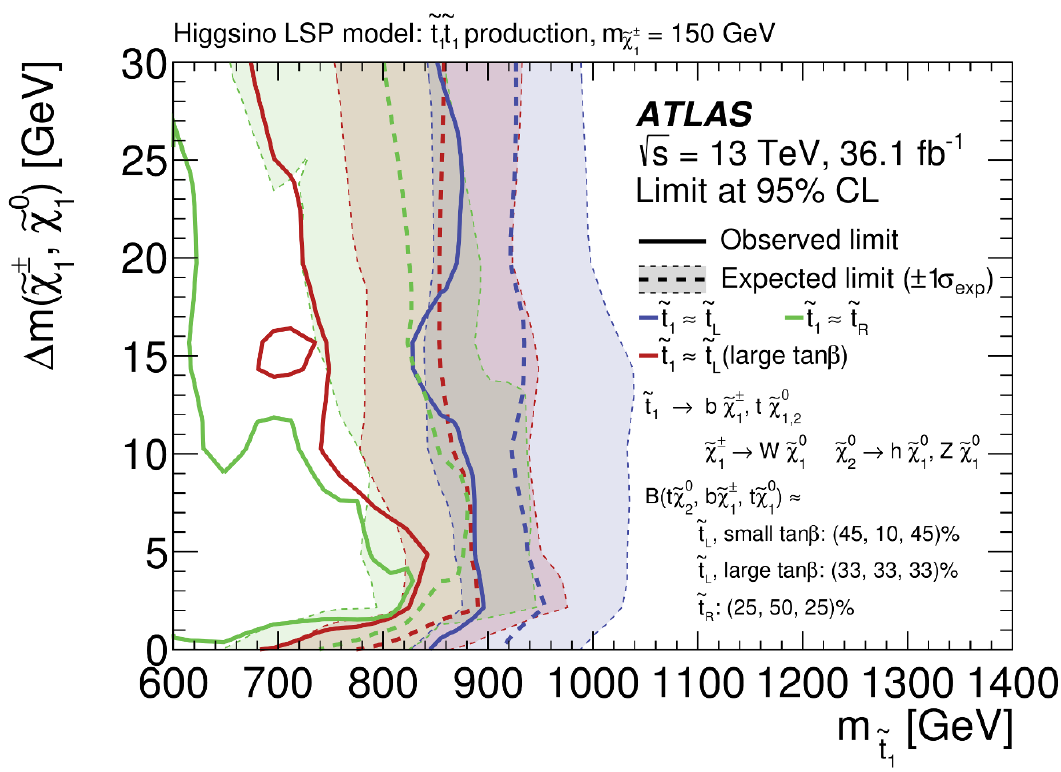
Figure 24 . Expected (dashed) and observed (solid) 95% excluded regions in the plane of (cid:1) m (~ (cid:31) (cid:6) ~ (cid:31) 0 for direct stop pair production in the (cid:12)xed m = 150 GeV higgsino LSP 1 ) versus m ~ t 1 , ~ (cid:31) (cid:6) 1 1 (cid:6) ~ t model where various decay modes (~ t b ~ (cid:31) t ~ (cid:31) 0 1 , ~ t t ~ (cid:31) 0 2 ) are considered with di(cid:11)erent 1 , 1 ! 1 ! 1 ! branching ratios, depending on the hypothesis being considered, and overlaid. In this model, the (cid:6) ~ (cid:31) 0 (~ (cid:31) (cid:6) ~ (cid:31) 0 mass relation of (cid:1) m (~ (cid:31) 0 2 ; ~ (cid:31) 0 1 ) = 2 (cid:1) m (~ (cid:31) 1 ) is assumed, varying (cid:1) m 1 ) from 0 GeV to 1 ; 1 ; (cid:2) (cid:6) ~ t ~ (cid:31) 0 30 GeV. For the region (cid:1) m ( ~ (cid:31) t ~ (cid:31) 0 1 decay is considered while the 1 ) < 2 GeV, only the 1 ; 1 ! branching ratio is set to account for both the ~ t t ~ (cid:31) 0 1 and ~ t t ~ (cid:31) 0 2 1 ! 1 !